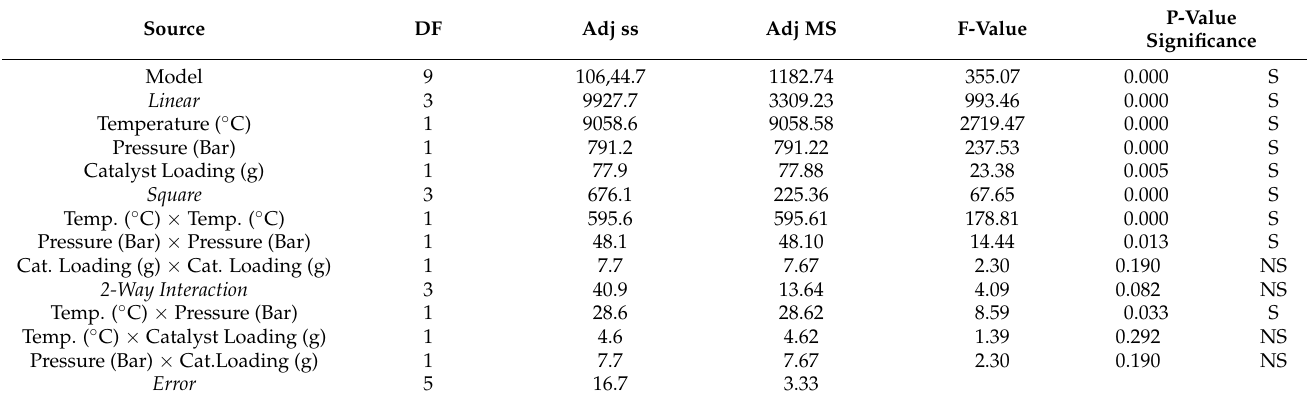
Table 2. Results of analysis of variance for hydrodeoxygenation of vanillin.